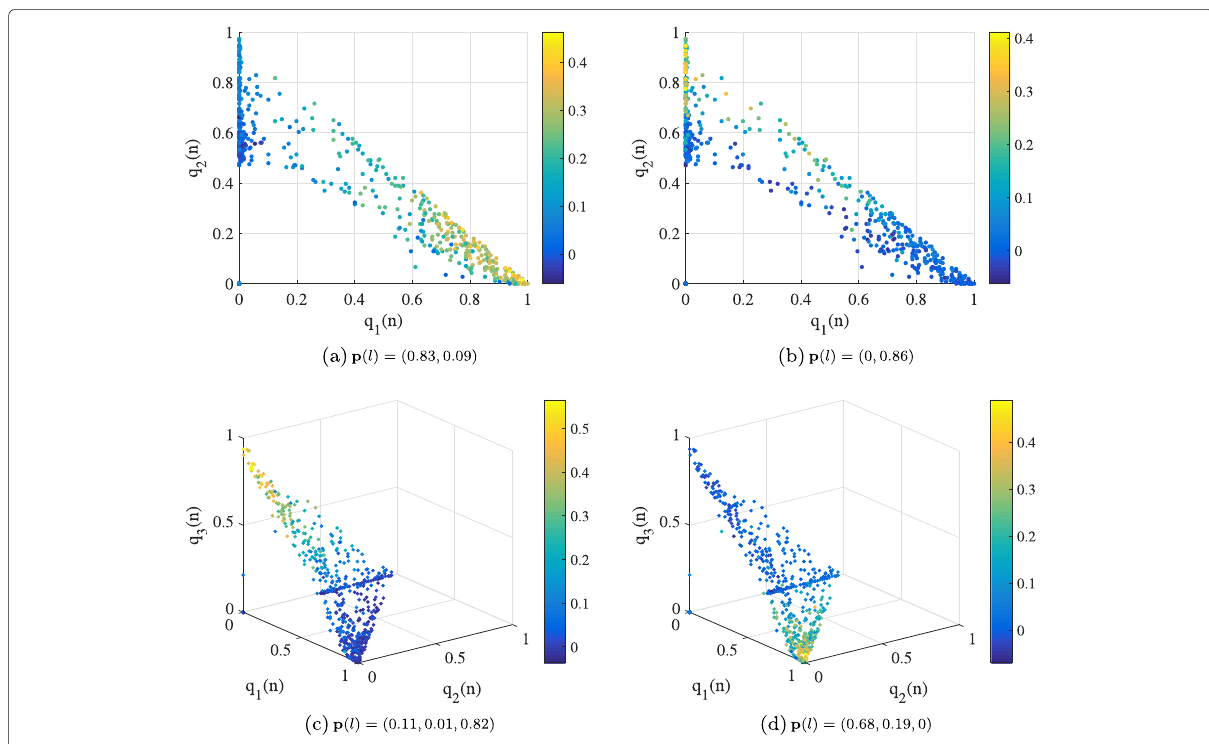
Fig. 1 Scatter plot of a , b t l ( q 1 , q 2 ) and c , d t l ( q 1 , q 2 , q 3 ) . The position of each point is according to a , b [ q 1 , q 2 ] or c , d [ q 1 , q 2 , q 3 ], and the color coding is according to the function value at each point Note that according to (21), hence, the criterion in (22) amounts to selecting the frame with lowest activity probability of the speakers that were already detected. The proposed maximum correlation method is summarized in Algorithm 1.